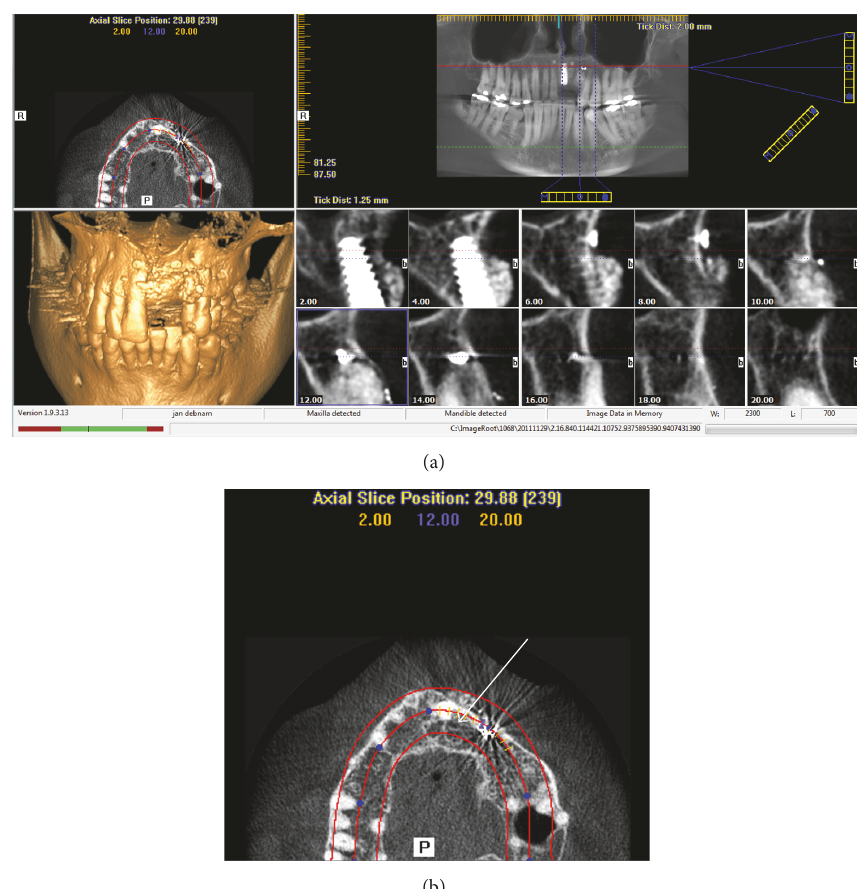
Figure 6: (a) Postoperative CBCT (iCAT) imagery taken at implant clinic to investigate for pathology at osteotomy site 21. The cross-sectional views show that the implant has penetrated the anterolateral wall of the nasopalatine duct. Additionally, the xenograft granules are shown as remaining separate from the alveolus buccal to the implant. (b) Magnified axial image from (a) again showing that a well-demarcated canal is present between the apex of tooth 23 and the nasopalatine duct and palatally to the newly placed implant, white arrow.